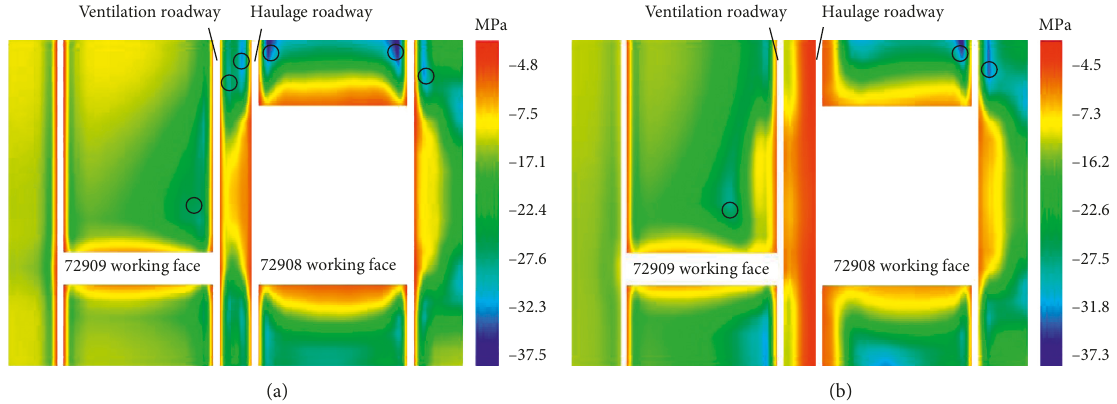
Figure 10: Vertical stress distribution of the roof strata of the 72908 haulage roadway (a) without presplitting blasting and (b) with presplitting blasting.